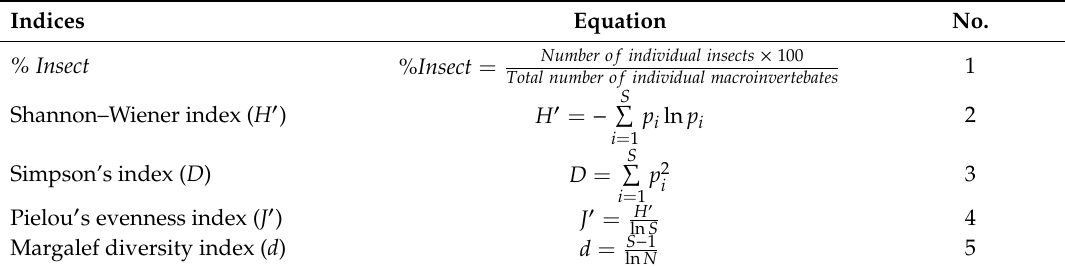
Table 2. Equations of di ff erent indices, where p i is the proportion of individuals found of taxon i , S is the total number of taxa and N is the total number of